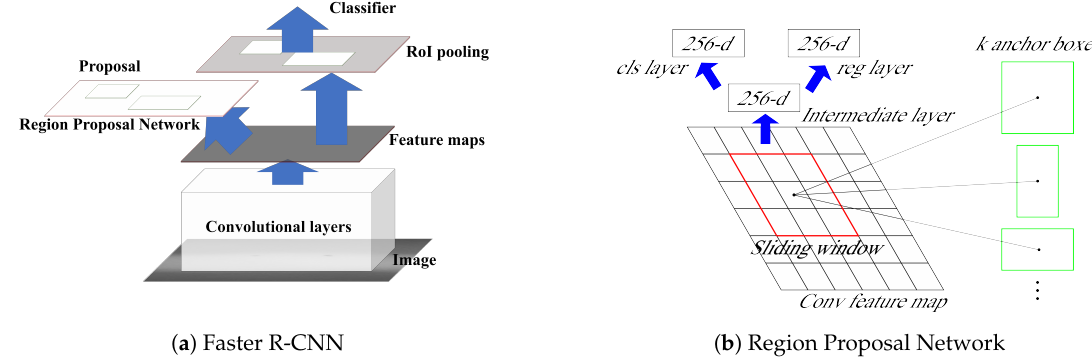
Figure 2. ( a ) Faster R-CNN structure. ( b ) RPN takes an image as input and outputs a set of rectangular object proposals, each with an objectness